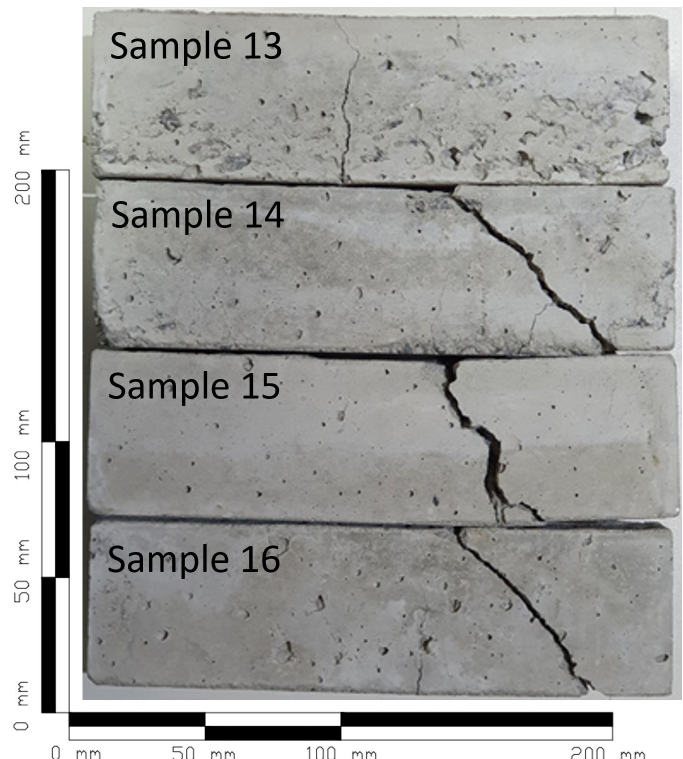
Figure 17. Cracking propagation behavior of reinforced concrete beams (Samples 13 to